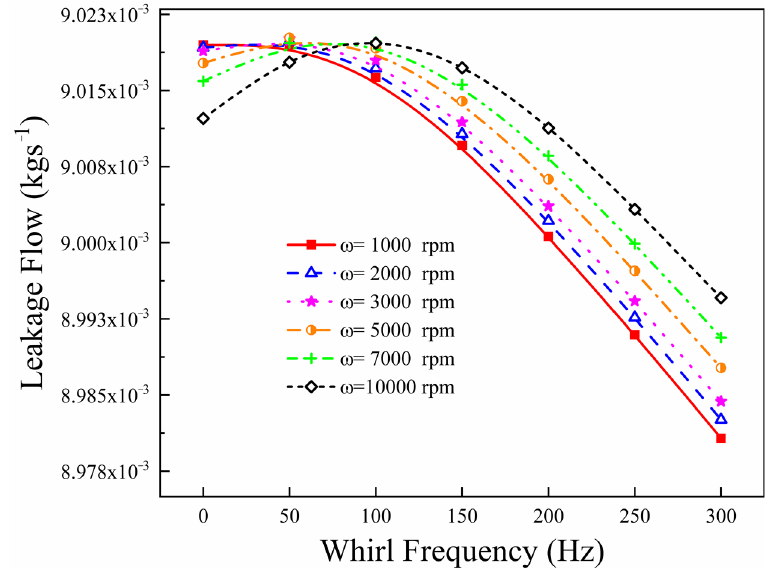
Figure 21. Leakage performance of HDLS at different whirl frequencies.